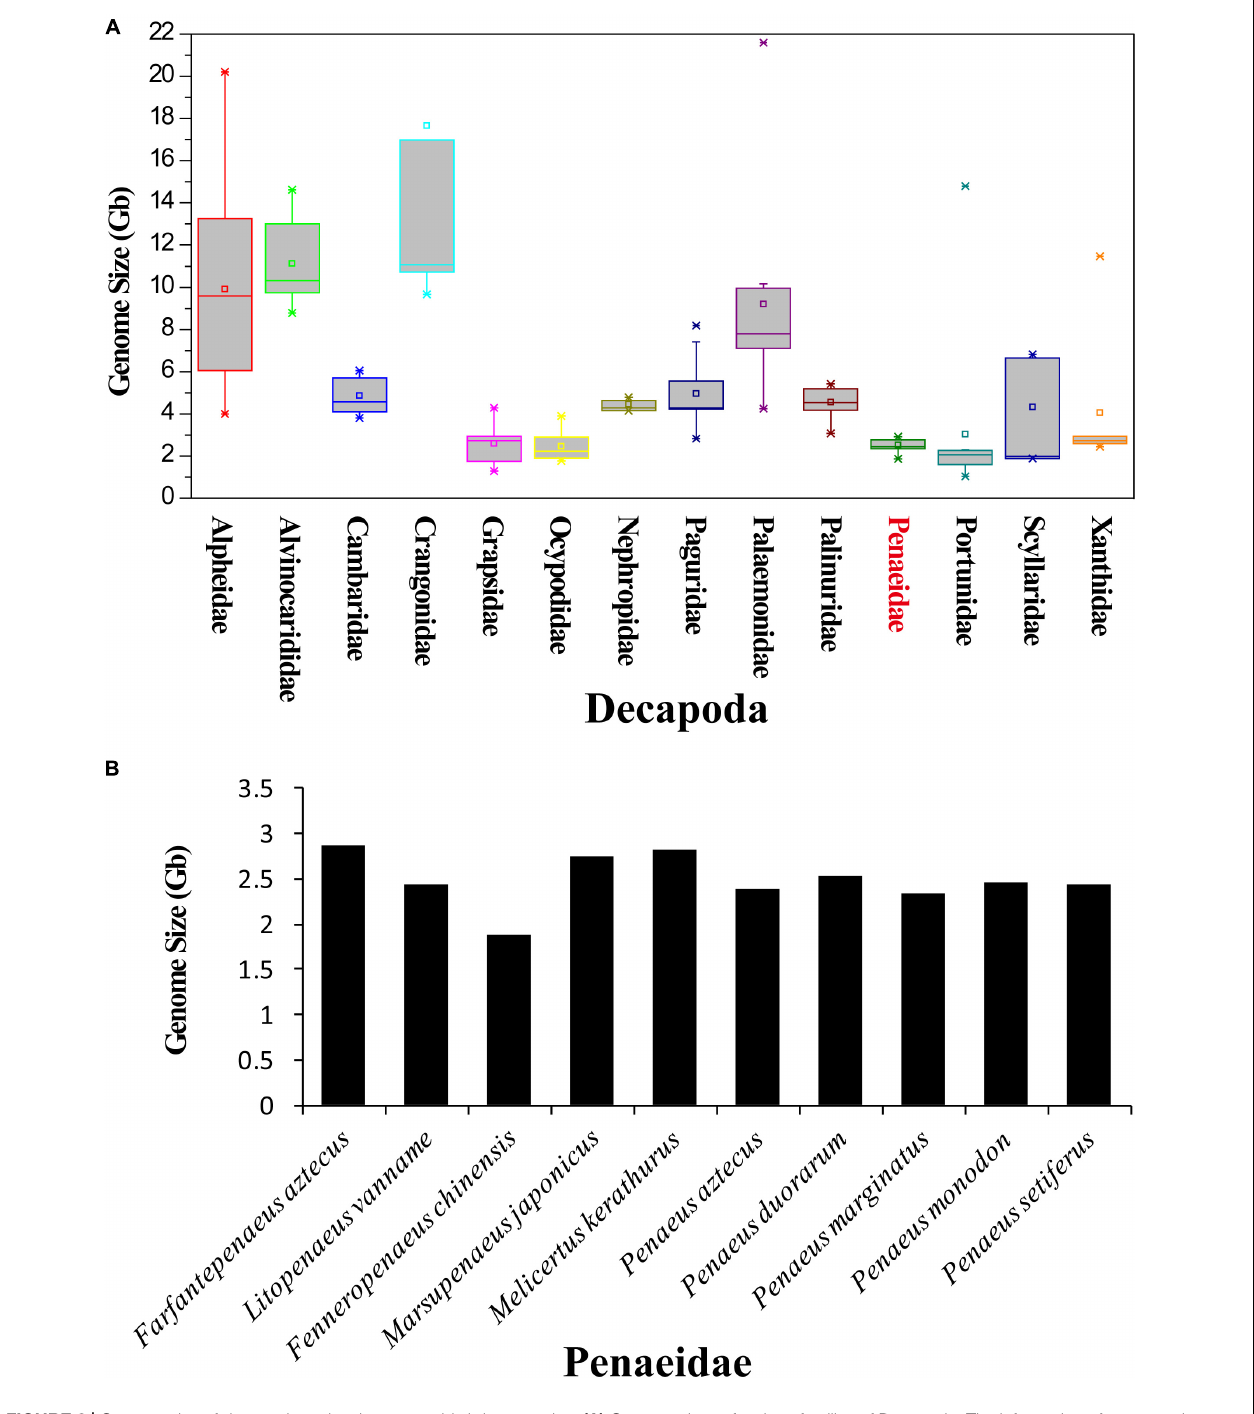
FIGURE 2 | Genome size of decapods and various penaeid shrimp species. (A) Genome sizes of various families of Decapoda. The information of genome sizes was obtained from the Animal Genome Size Database (www.genomesize.com). (B) Genome sizes of various penaeid shrimp species.